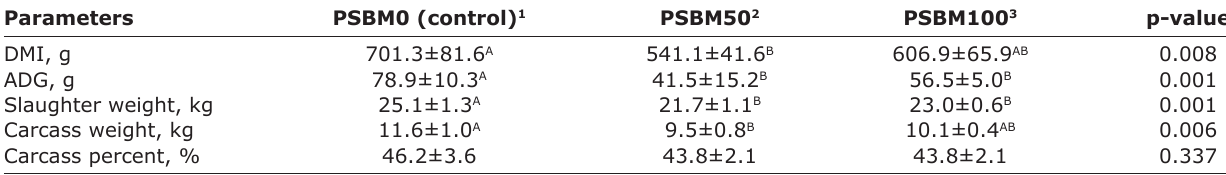
Table-1: The DMI, ADG, slaughter weight, carcass weight, and carcass percentage. Parameters